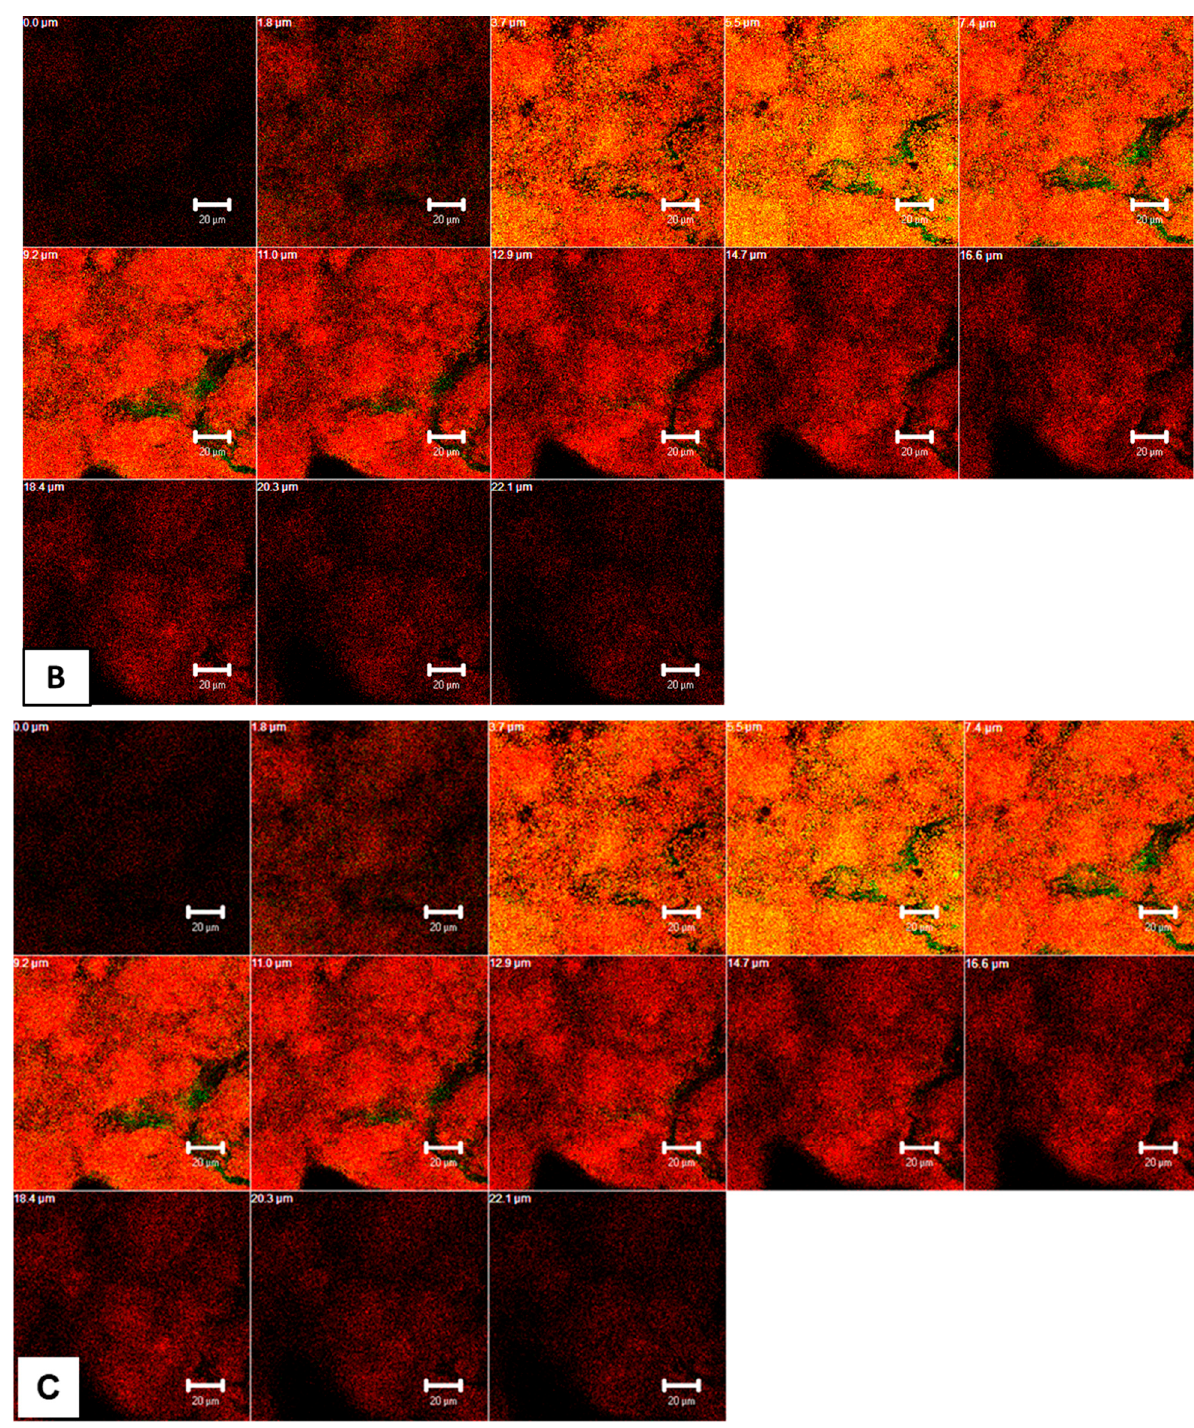
Figure 5: Representative confocal laser scanning microscopic (CLSM) images after live/dead staining, demonstrate the application of antimicrobial photodynamic therapy (aPDT) on oral biofilm formation (3 d). The live (green) and dead (red) oral bacteria are depicted on the Z-section panels of the untreated negative control ( A ), 0.2% chlorhexidine-treated (CHX) positive control ( B ) and the biofilms treated with aPDT in the presence of tetrahydroporphyrin-tetratosylate (THPTS) ( C ). Multiple Z-sections were created by vertical sectioning in 2 µm intervals through the biofilm above the enamel surface, as shown in panels ( A – C ). Scale bar for all images is 20 µm.